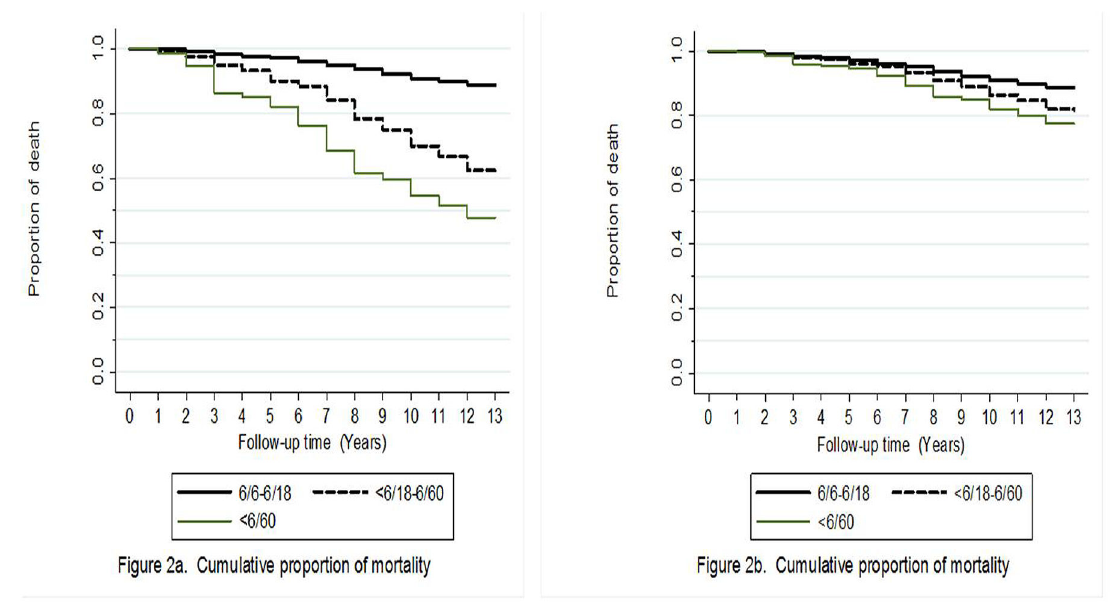
Figure 2. Survival curves for visual impairment and mortality: a) Unadjusted and b) Adjusted for age and gender.